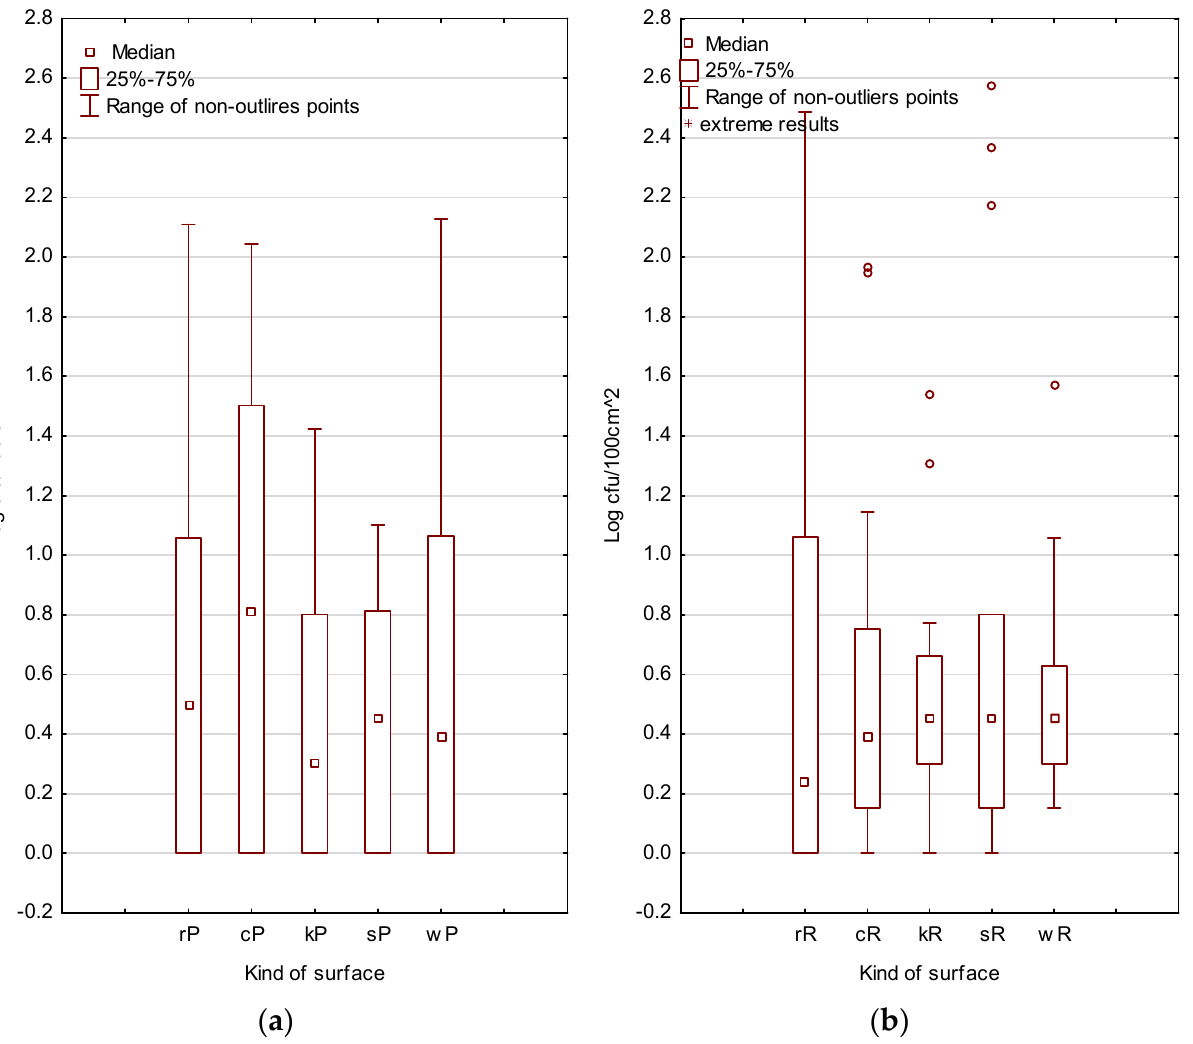
Figure 3. Mean contamination of S. aureus on analysed surfaces in food truck outlets ( n = 20). ( a ) Petrifim method (P). ( b ) Reference method (R). rP, rR—refrigerator; cP, cR—cutting board; kP, kR—knife; sP, sR—serving board; wP, wR—working board.